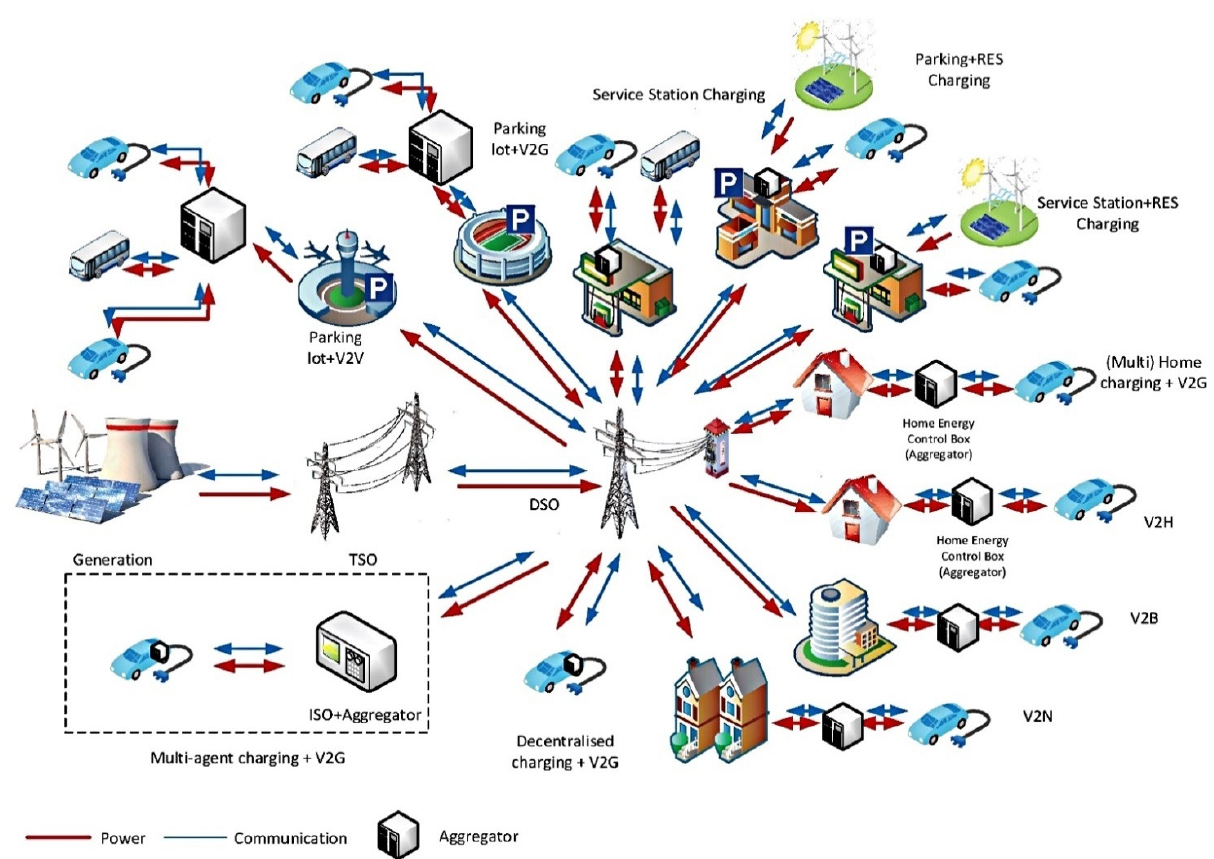
Figure 5. Concept of V2G and V2H